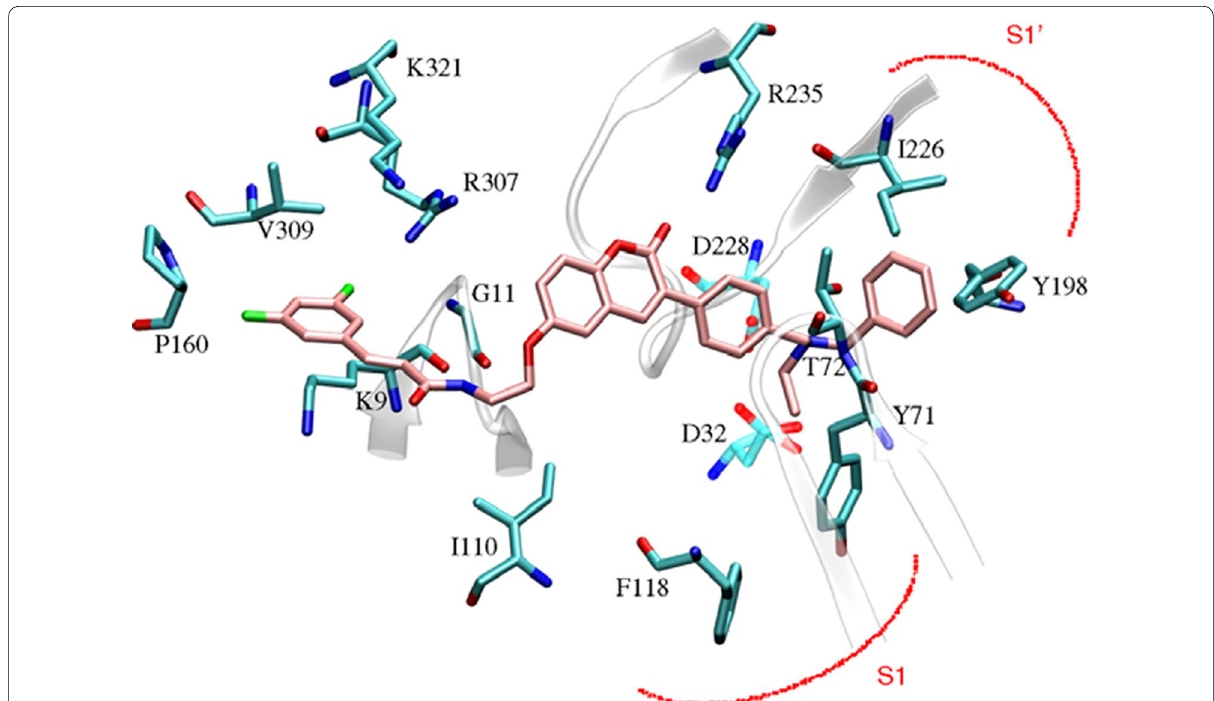
Fig. 74 Proposed binding mode of compound C87 H docked at the active site of BACE1 [15]